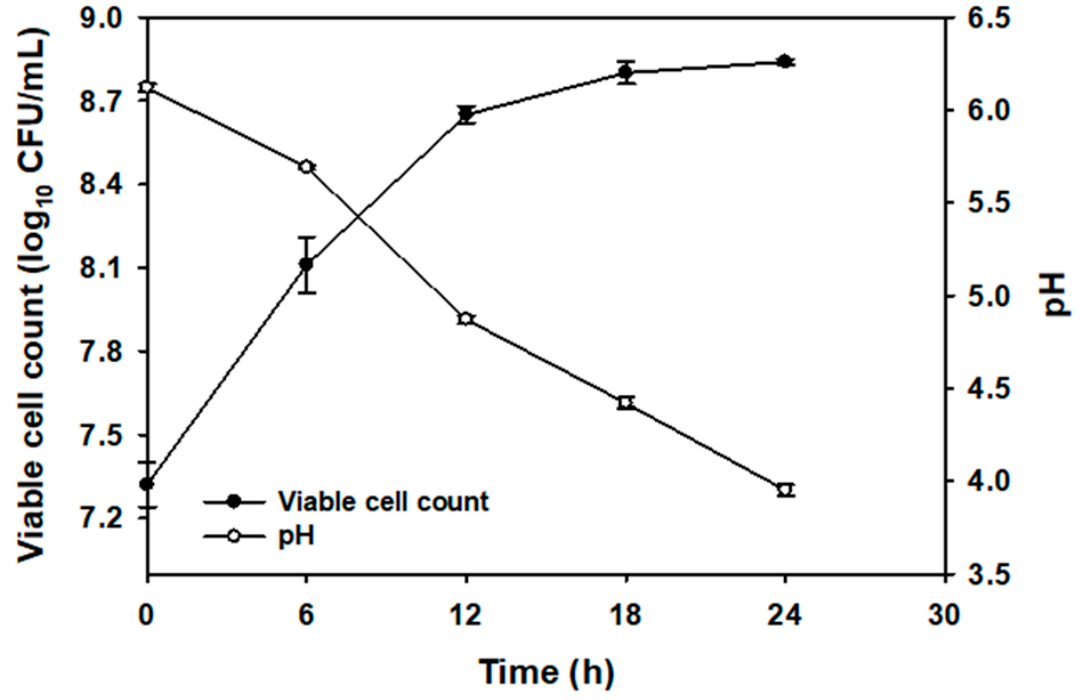
Figure 1. Changes in L. plantarum growth and pH during 24 h of fermentation of Chinese chive (CC) juice (25%, volume per volume ( v/v )).